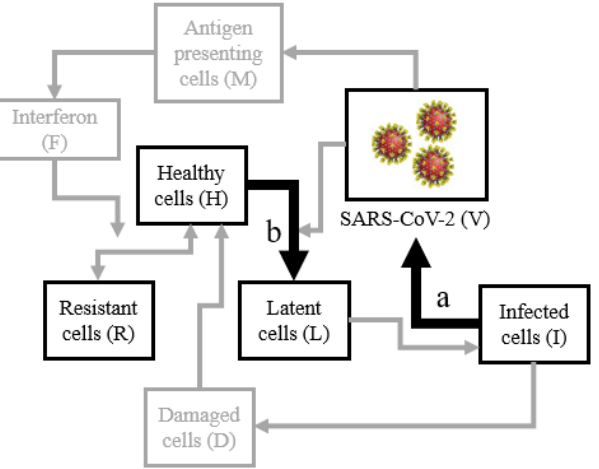
Figure 1. The key interactions of the in-host model where Remdesivir therapy are modeled by controlling the rate parameter at interaction (a) and host-cell entry inhibition therapy is modeled by interaction (b).